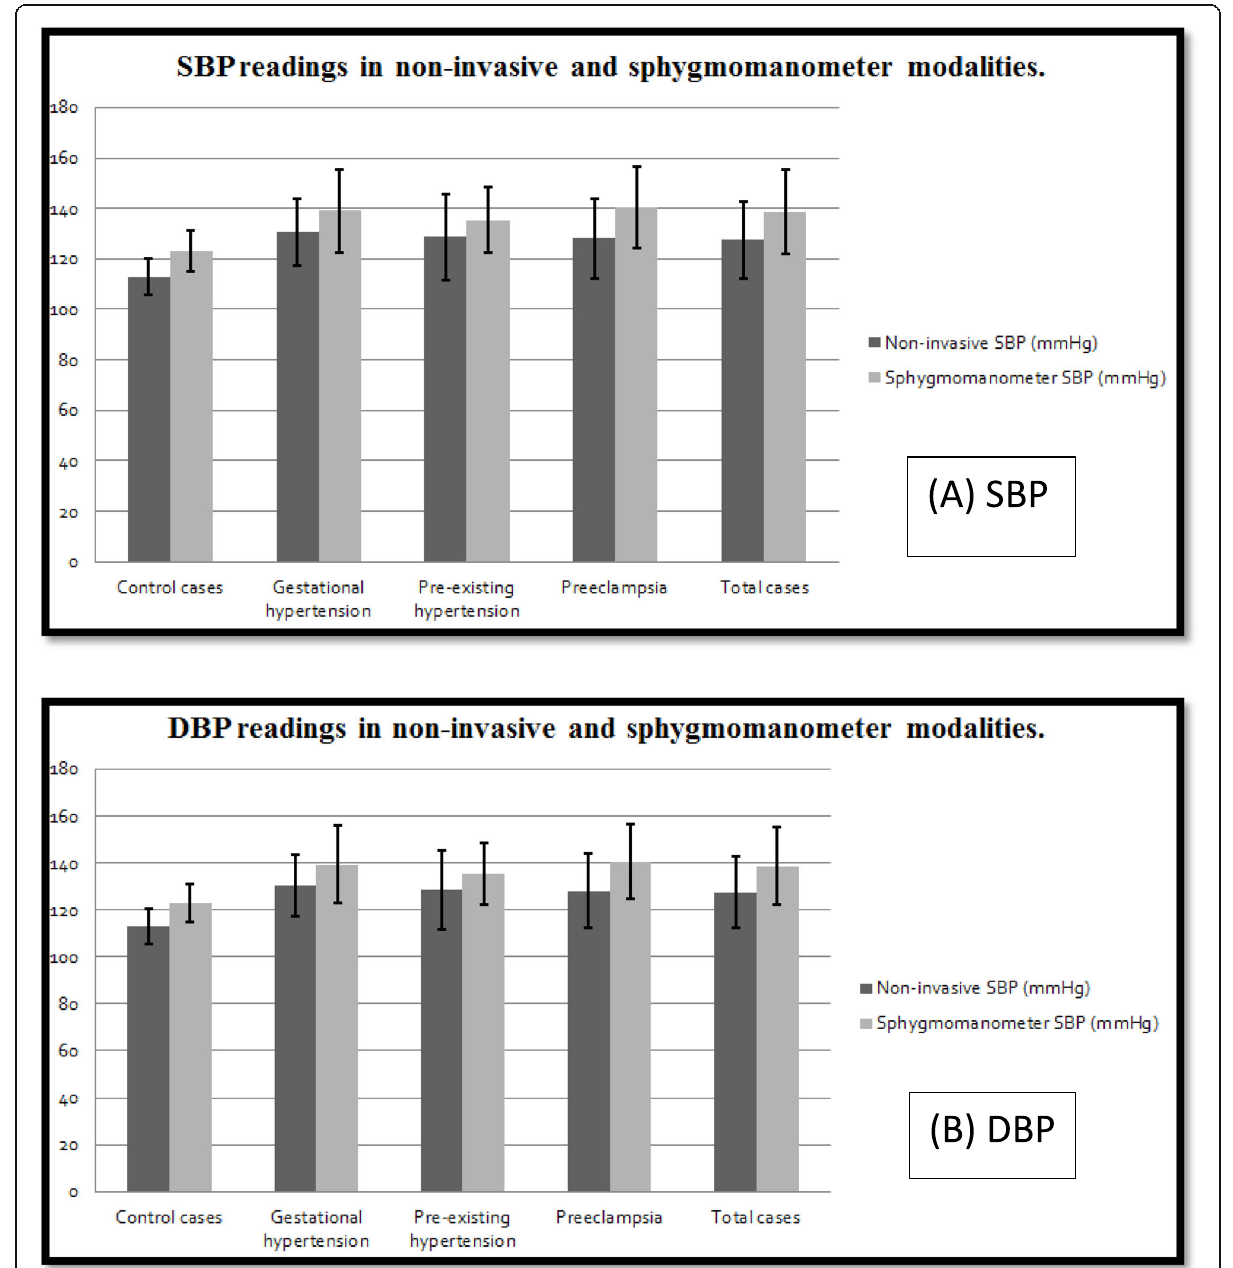
Fig. 3 Difference between central non-invasive BP and sphygmomanometer in both. a Mean Systolic blood pressure in non-invasive central vs sphygmomanometer modality. b Mean diastolic BP in noninvasive central vs sphygmomanometer modality. SBP, systolic blood pressure; DBP, diastolic blood